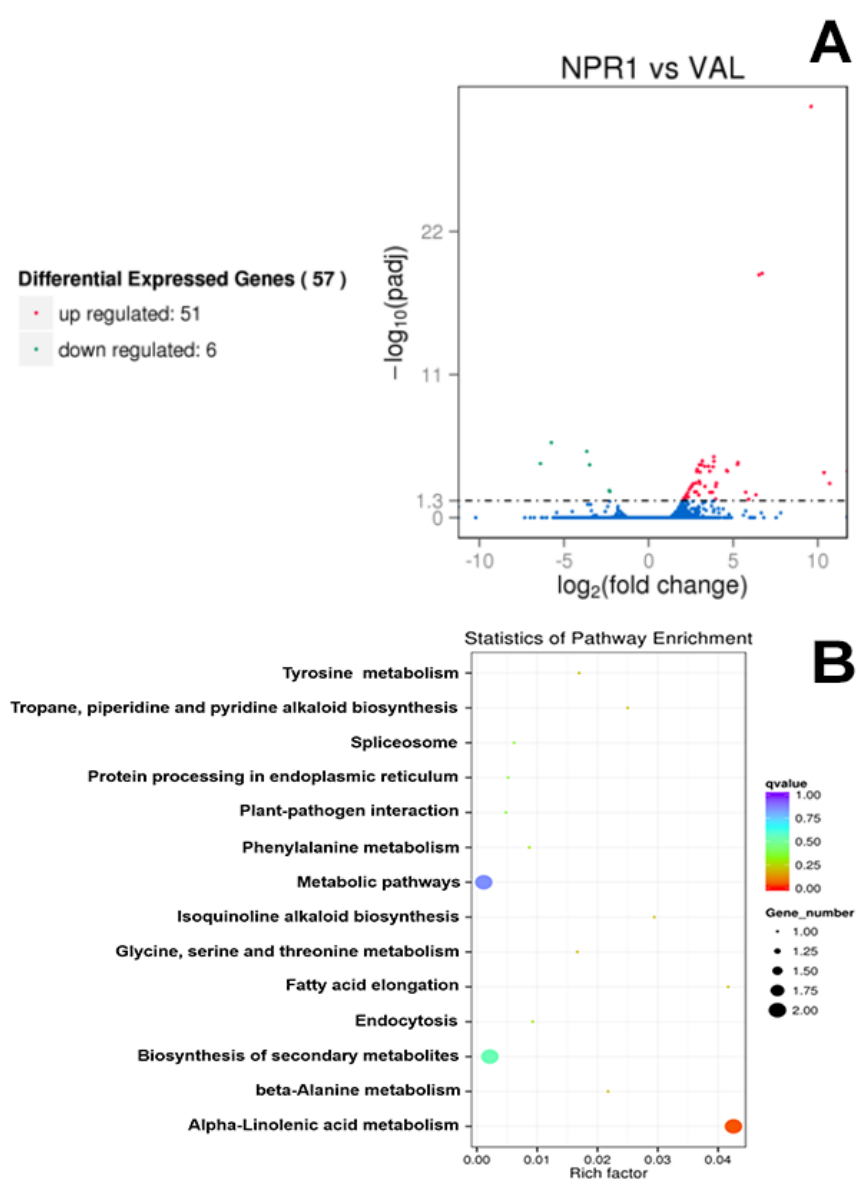
Figure 2. Analysis of the differentially expressed genes (DEGs). ( A ) DEGs between the transgenic NPR1 overexpressing line (NPR1-2) and control non-transgenic ‘Valencia’ line; ( B ) Kyoto Encyclopedia of Genes and Genomes (KEGG) enrichment scatter plot of DEGs. The y-axis shows the name of the pathway and the x-axis shows the Rich factor. Dot size represents the number of different genes and the color indicates the q-value. Table 2. List of all DEGs between the NPR1-2 transgenic line and control non-transgenic ‘Valencia’ line.